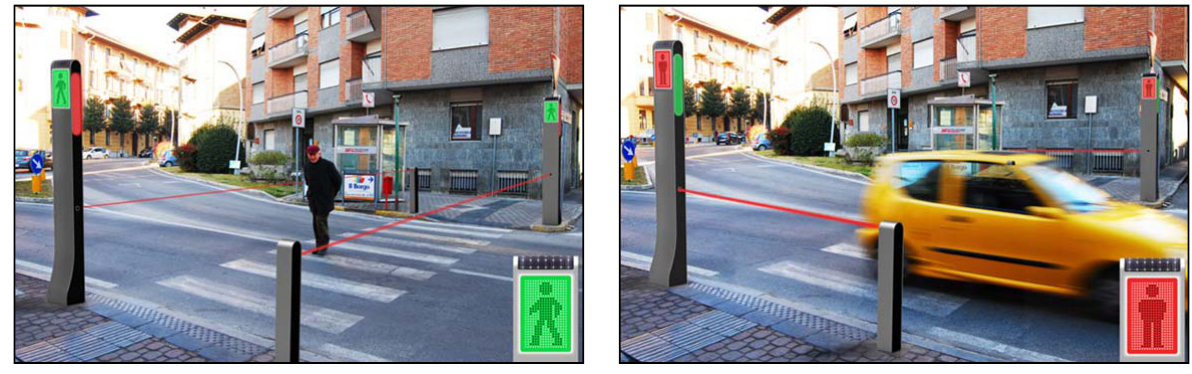
Figure 4. Inteligent crossing – Guardian.